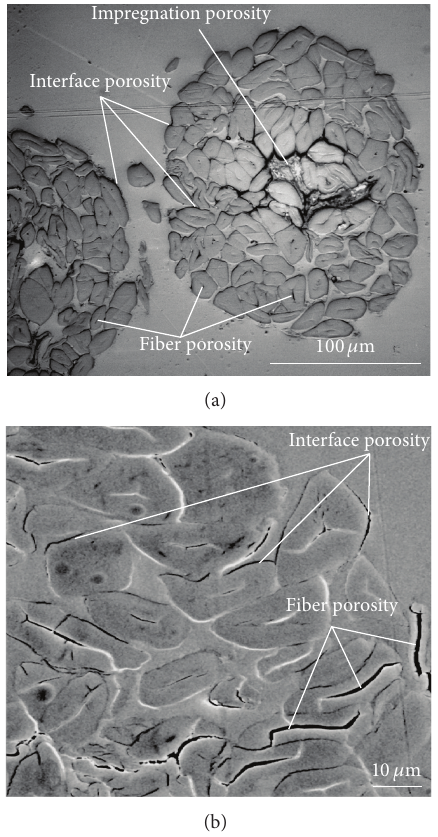
Figure 6: Types of porosity in cellulose fiber composites. Shown are cross-sectional images of unidirectional hemp fiber/polyethylene terephthalatecomposites.Theopticalmicroscopeimagein(a)shows a hemp fiber yarn, and the scanning electron microscope image in (b) shows a close-up of the fibers in the yarn [62].